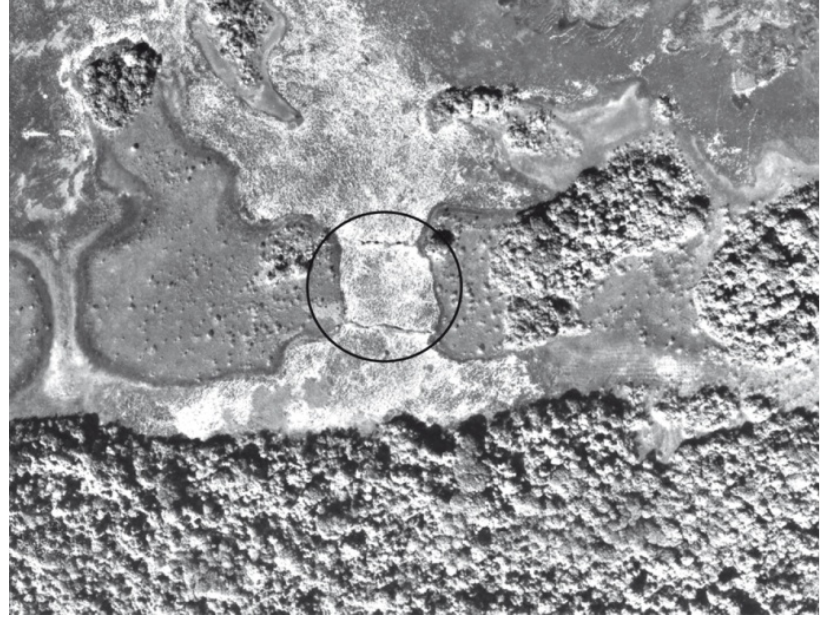
Figure 10. Belt ditches measuring 90 m longcircling a raised-field complex near Kourou (photo IGN 1987).